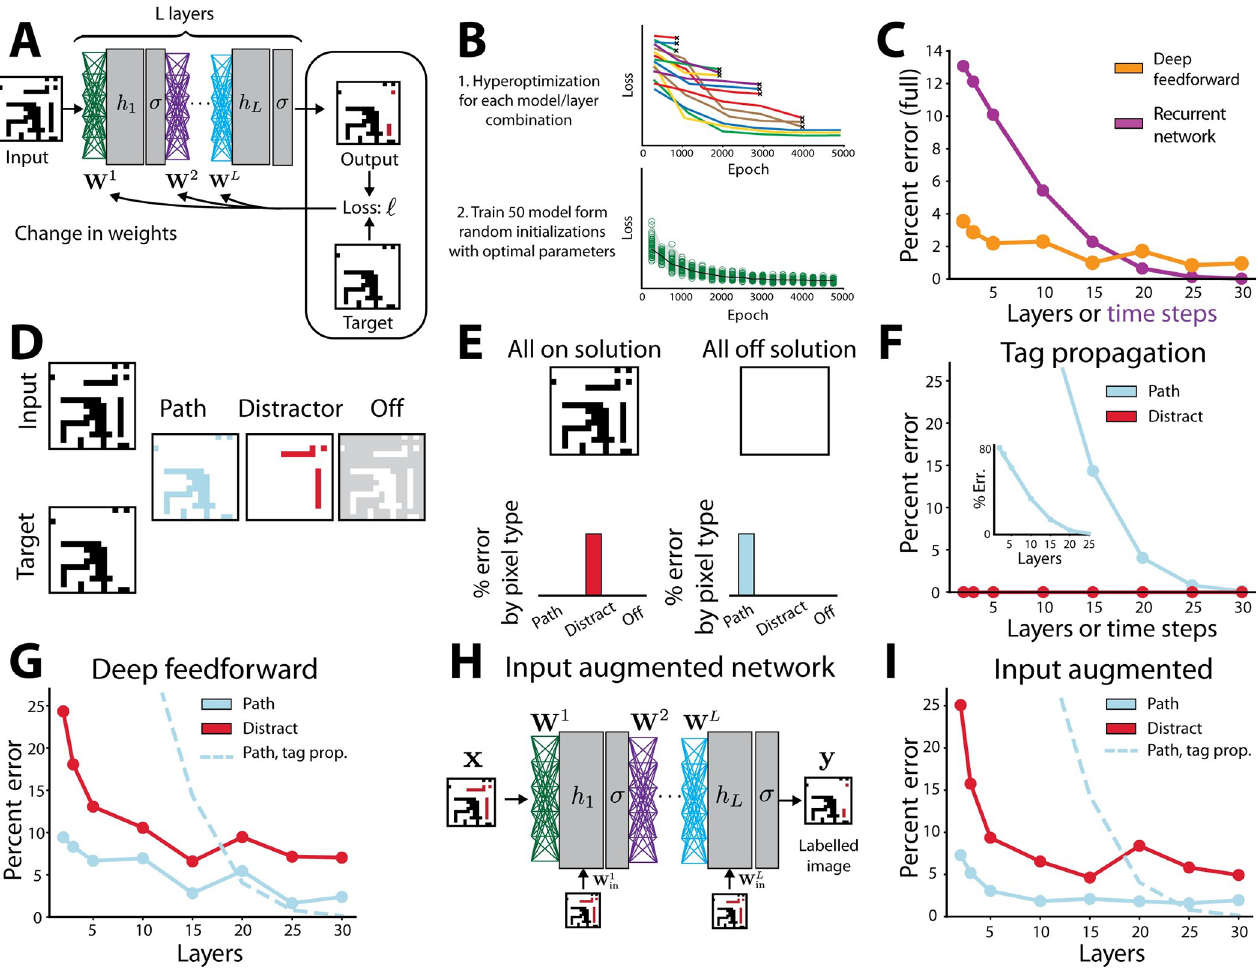
Fig 2. Feedforward network performance on the edge-connected pixel task. (A) Training procedure for neural networks. Weights are learned iteratively. At each iteration the weights are updated using the gradient of the loss function calculated via backpropagation. The network illustrated here is a deep feedforward network. The image is given as input to the first layer and the activation of units at the last layer is the network’s output. (B) Schematic of the two-part procedure used to obtain good solutions despite the stochasticity of learning and the large parameter spaces. First, hyperoptimization is performed over the training parameters for each model and layer combination (top). Each line corresponds to a network being trained, colored differently to indicate the different hyperparameters used. The worst performing models are eliminated at regular intervals (see Methods for full details). Second (bottom), 50 models are trained from random initialization, all using the optimal parameters found in the hyperoptimization procedure. (C) Performance of the best trained solution for the deep feedforward network across layers vs. the recurrent tag propagation solution. X-axis corresponds to number of layers in the network for the feedforward solution, and number of time-steps the network is allowed to run for the recurrent solutions, which have only one layer of recurrently connected neurons. (D) Illustration of the splitting of pixels, and associated errors, into three groups: path, distractor, and off. (E) Breakdown of errors for two na ï ve solutions: all on, outputting all the on-pixels as connected, and all off, outputting no pixels as connected. (F-G) Decomposition of error by pixel type for each model. (F) Tag propagation implemented via recurrent network. X-axis corresponds to the number of time-steps the network is allowed to run. Blue dots and line correspond to errors on path pixels, red dots and line correspond to errors on distractor pixels. Inset shows same data with larger axis range. (G). X-axis corresponds to number of layers in the network. Blue dots and line correspond to errors on path pixels, red dots and line correspond to errors on distractor pixels. Dashed line corresponds to tag propagation error on path pixels for reference. (H) Schematic of input augmented architectures where the full image is added as input at each layer, allowing the tag propagation solution to be part of parameter space. (I) Decomposition of error by pixel type for the input augmented network. Same plotting convention as